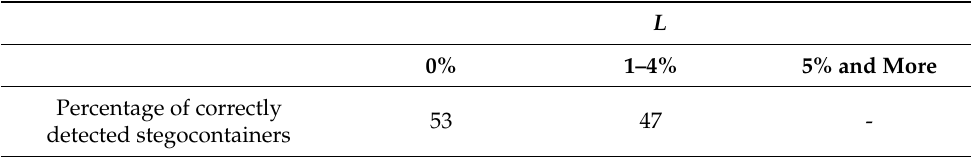
Table 2. RS analysis on a set of 225 × 225 containers filled with 21% interpolation method.